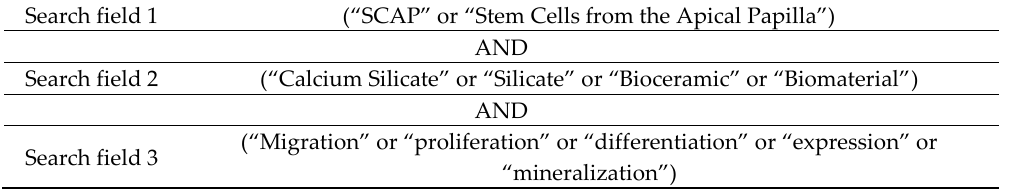
Figure 1. Search strategy illustration.